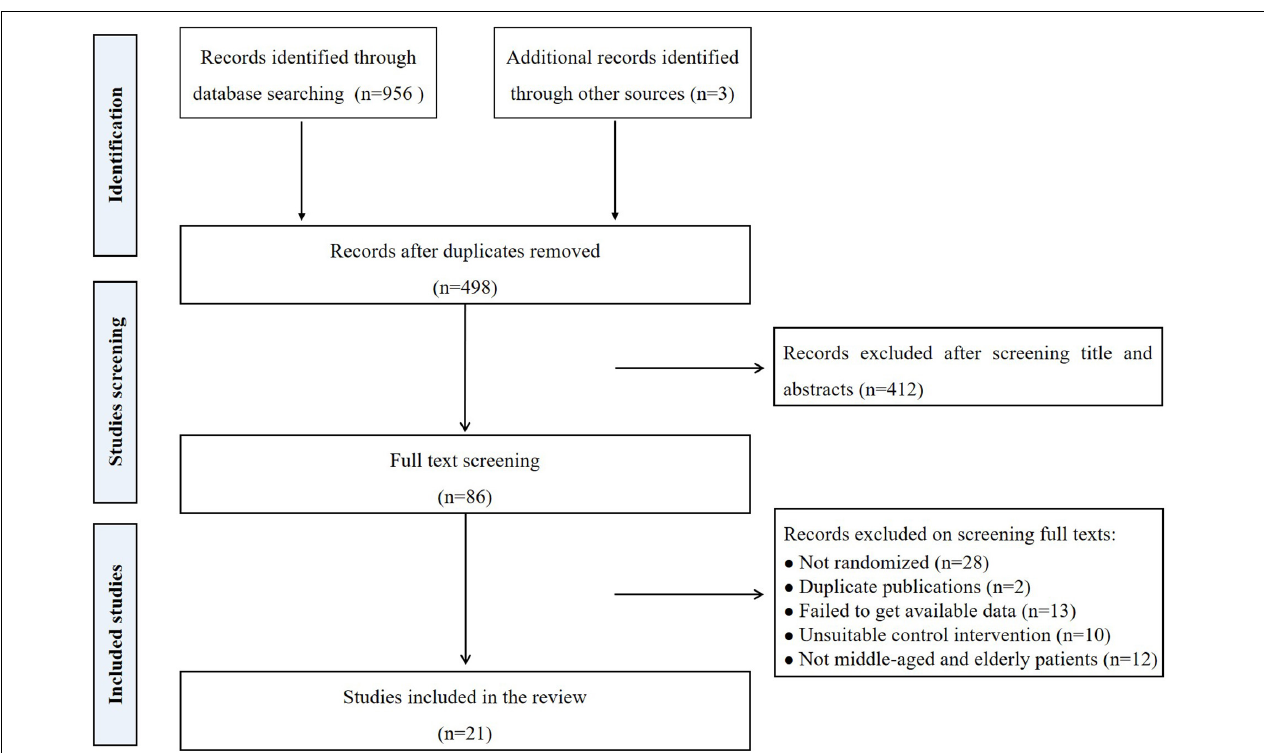
FIGURE 1 | Flow chart for the